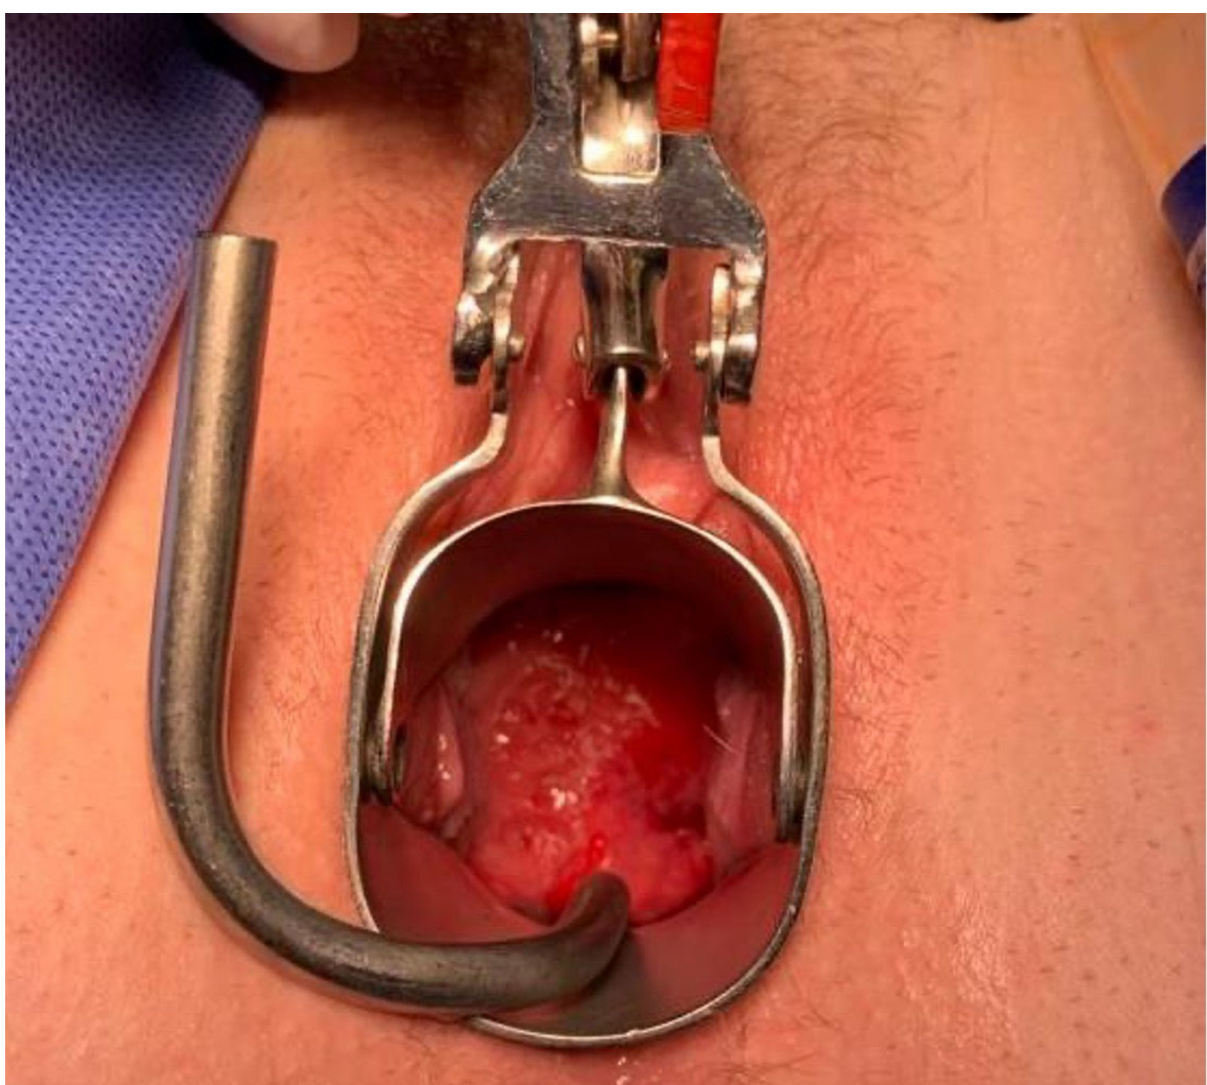
Figure 3. Vaginal assessment of the cervix, which appears to be completely replaced by the 5 cm exophytic